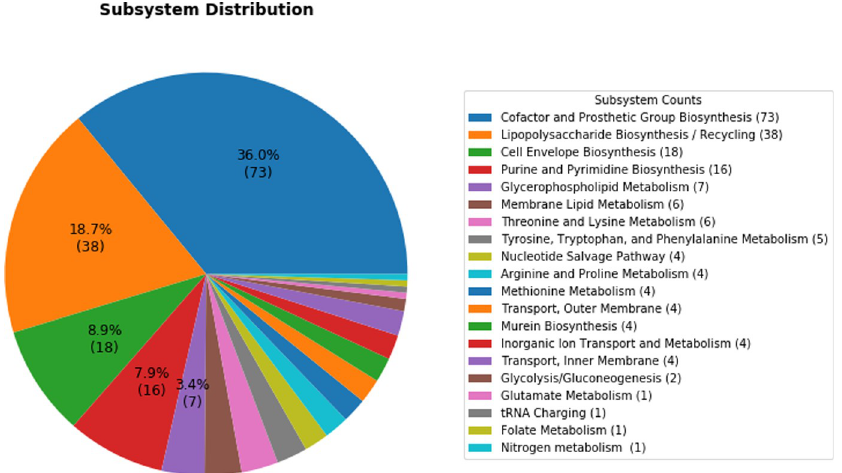
Fig 1. Subsystem distribution of 195 essential genes associated with their frequency.